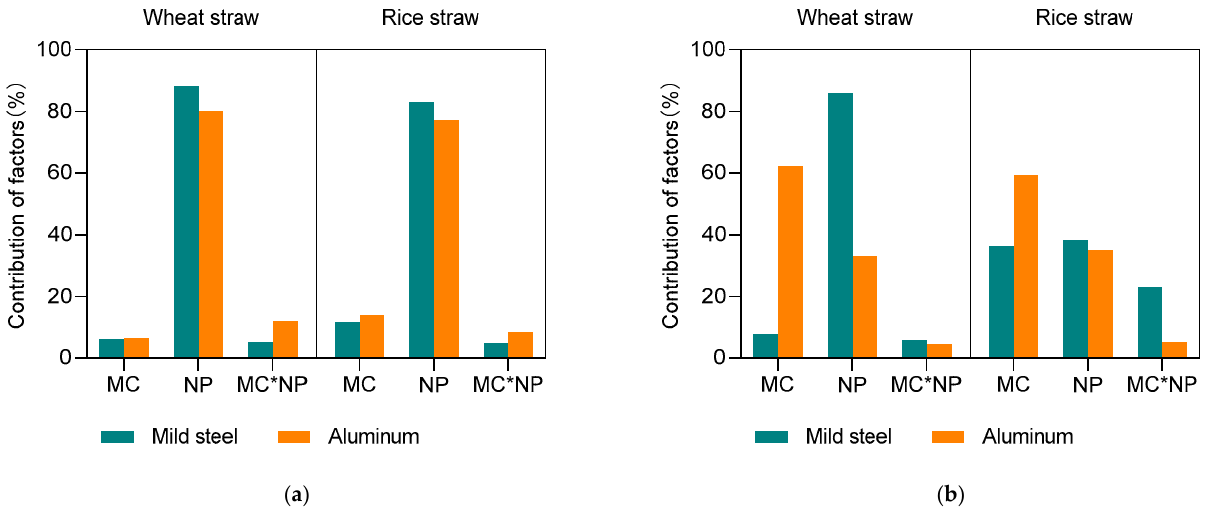
Figure 6. Contribution of factors to coefficient of sliding friction (( a ): untreated straw; ( b ): extrusion-exploded straw).